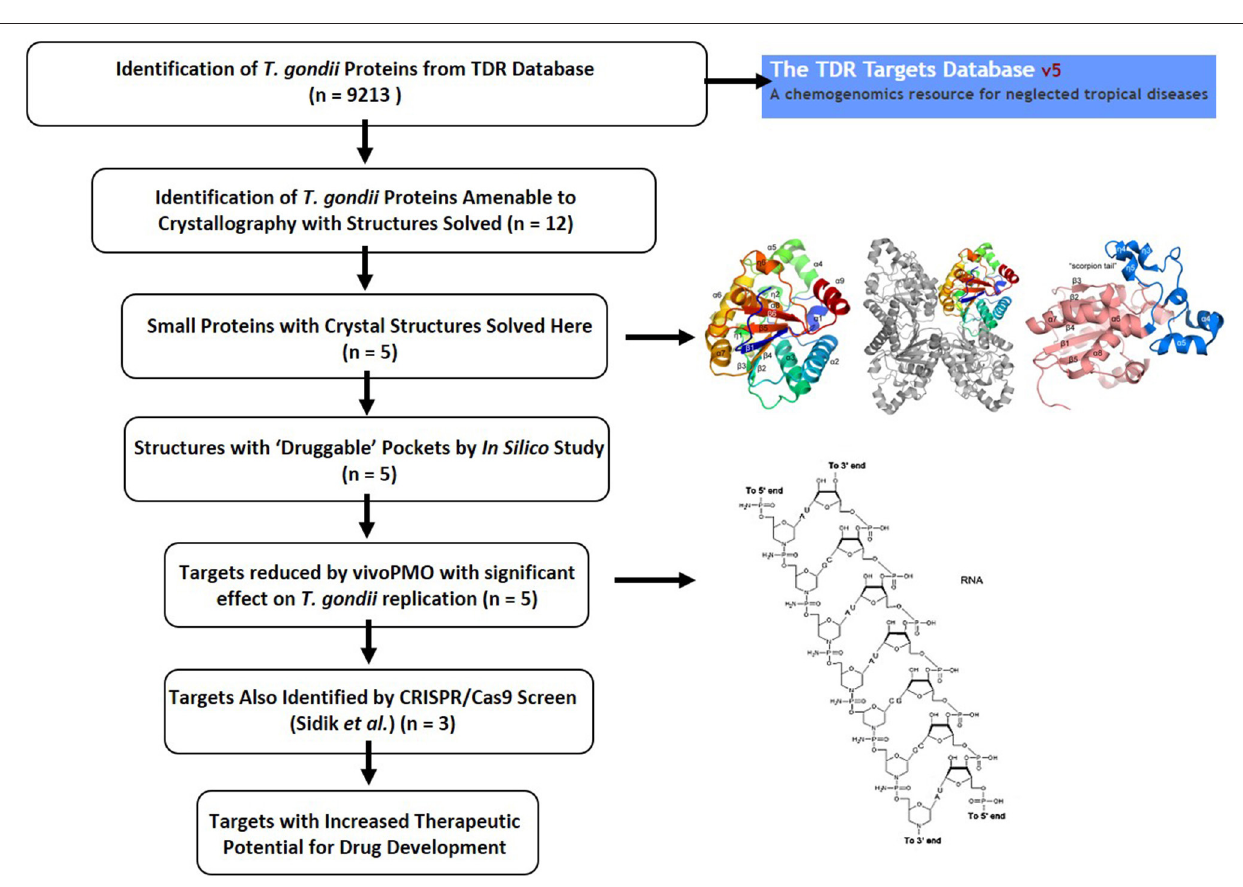
FIGURE 10 | Summary figure showing the T. gondii drug discovery pipeline as described herein. The TDR Database provided important initial insights into potentially important parasite proteins (Agüero et al., 2008; Magariños et al., 2012). Identification of proteins amenable to crystallographic analysis, solution of their structures, abrogation with vivoPMO and confirmation of essentiality by querying the CRISPR/Cas9 database completed the pathway, identifying enriched targets with improved therapeutic